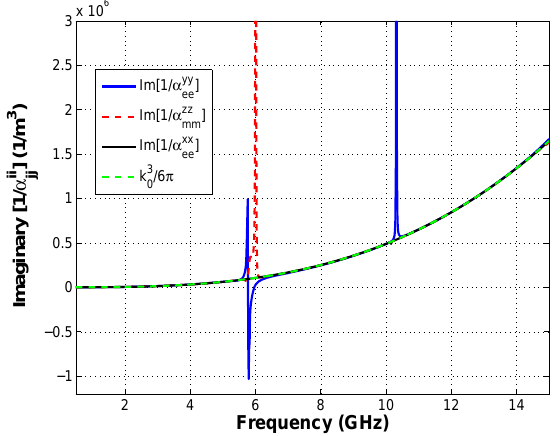
Figure 13: Comparison of the Sipe-Kranendonk criterion for lossless scatterers with the polarizabilities of the NB-SRR extracted in Fig. 11. The criterion is not satisfied on reso- nance bands, where the anisotropic assumption is not